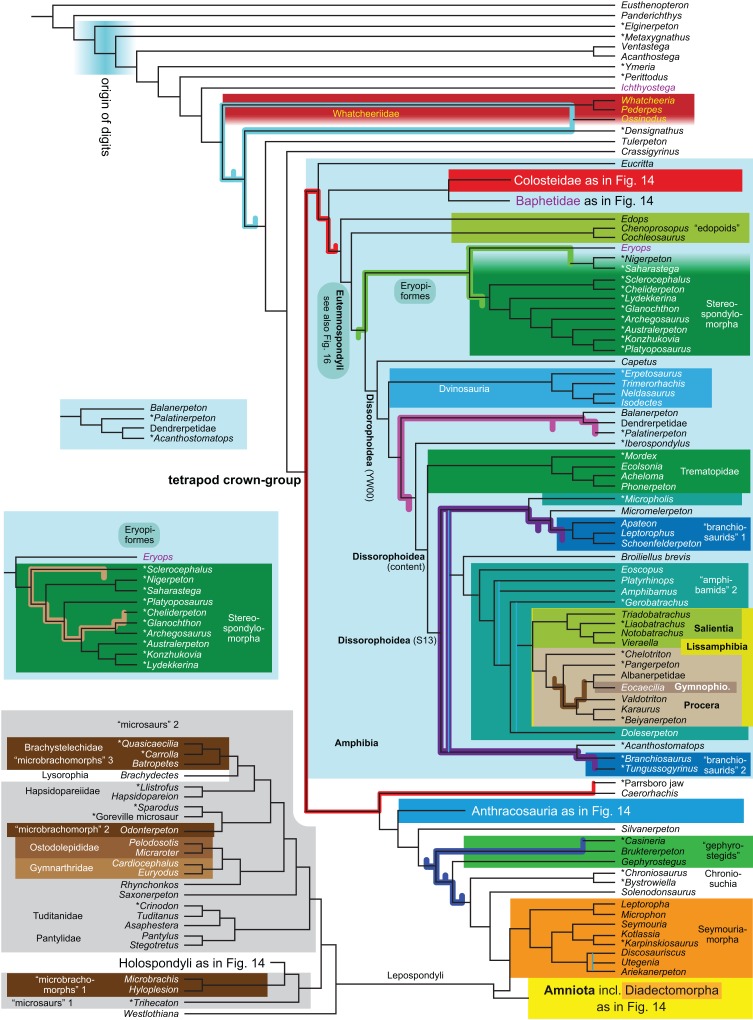
Representation of some MPTs (length: 3,021 steps) resulting from Analysis R5 (revised matrix, expanded taxon sample, constraint against the LH as in Analysis R2).The insets at the left show two equally parsimonious alternative to parts of the temnospondyl topology shown in the main tree. The remaining MPTs from R5 are represented in Fig. 16; the differences are again limited to eutemnospondyl phylogeny (Eutemnospondyli being the sister-group of Edops, as defined by Schoch, 2013). Teal, red, green and dark blue underlays as in Fig. 14, though note a fourth position for (*Nigerpeton + *Saharastega) in the lower inset. Further underlay colors: magenta: *Palatinerpeton (three positions); violet: *Tungussogyrinus (3); light brown: *Cheliderpeton (2); dark brown: (Eocaecilia + Albanerpetidae) (2).